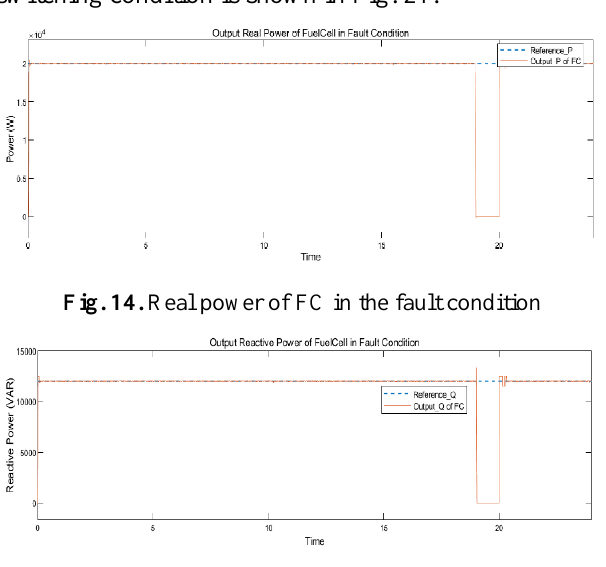
Fig. 15. Reactive power of FC in the fault